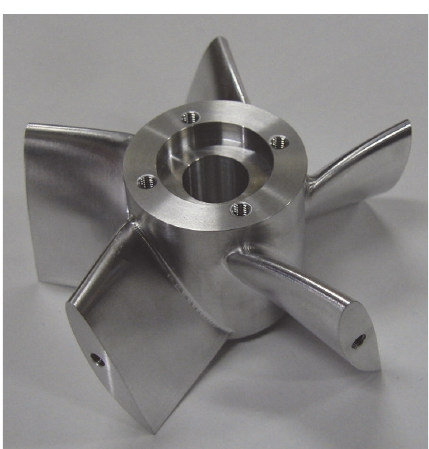
Figure 14: Actual device of the guide vane.